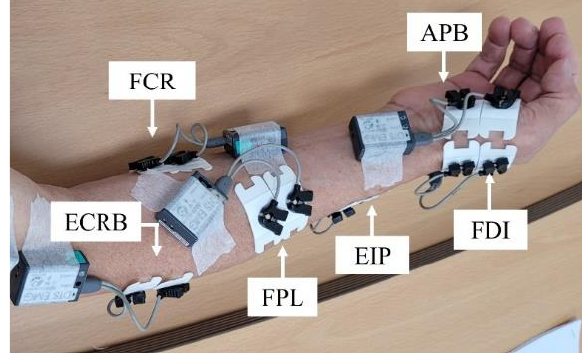
Figure 3. sEMG sensor position.